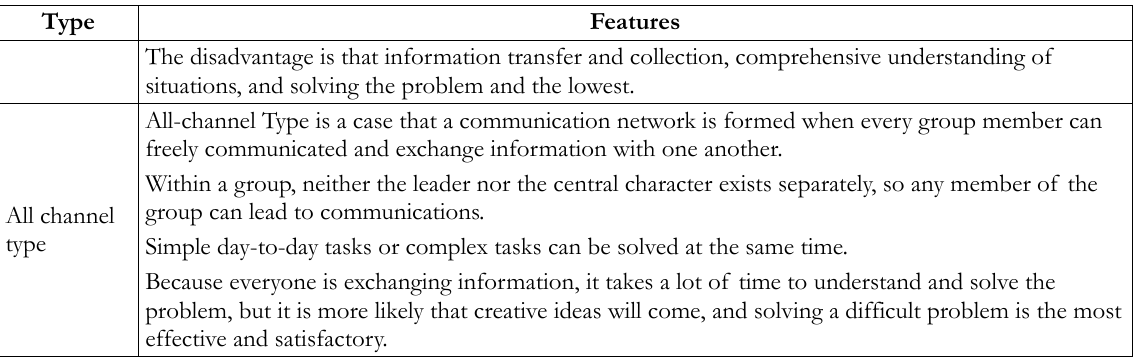
Table 4. Features of Communication Network Type